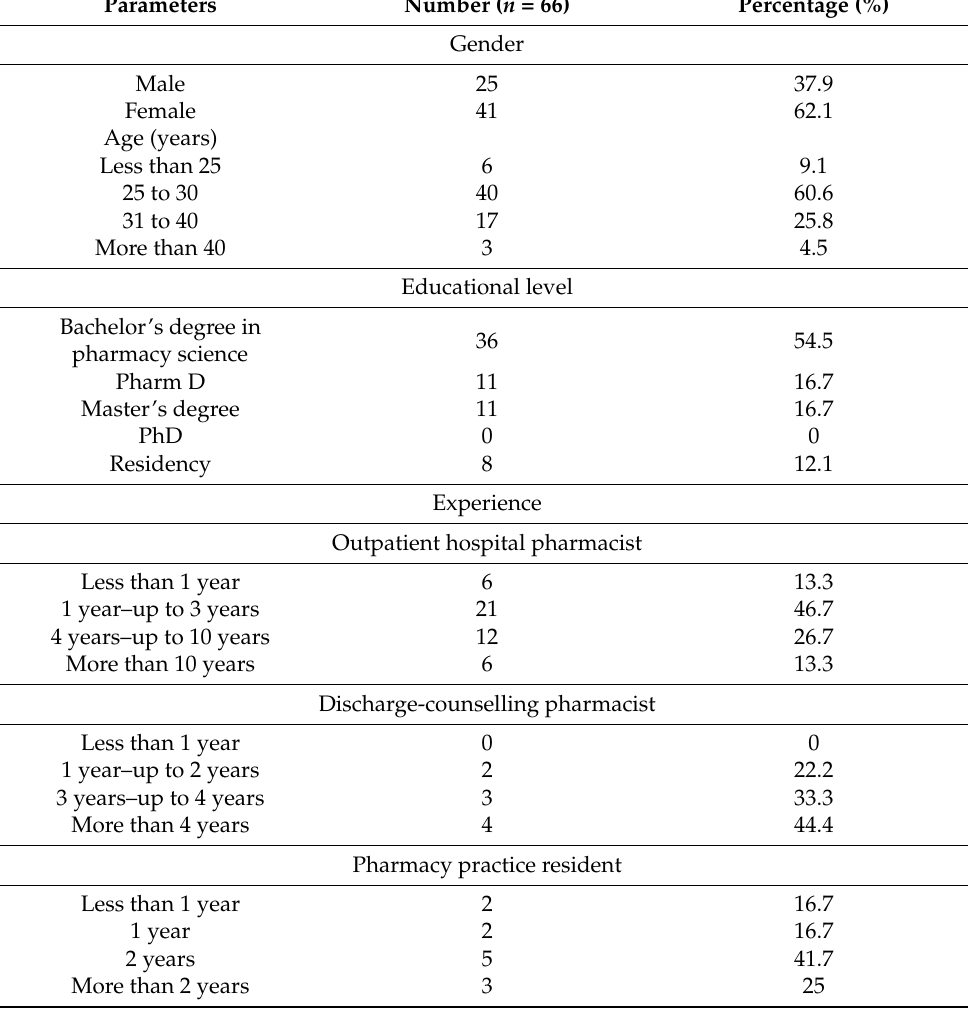
Table 1. Characteristics of the hospital